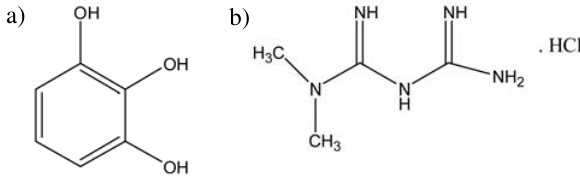
Figure 1: Chemical structures of PY (a) and MET